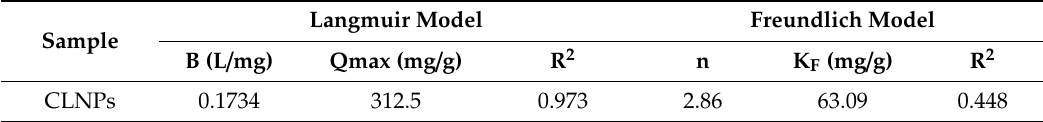
Table 4. Freundlich and Langmuir isotherm model parameters for the adsorption of Pb(II) onto CLNPs. Sample